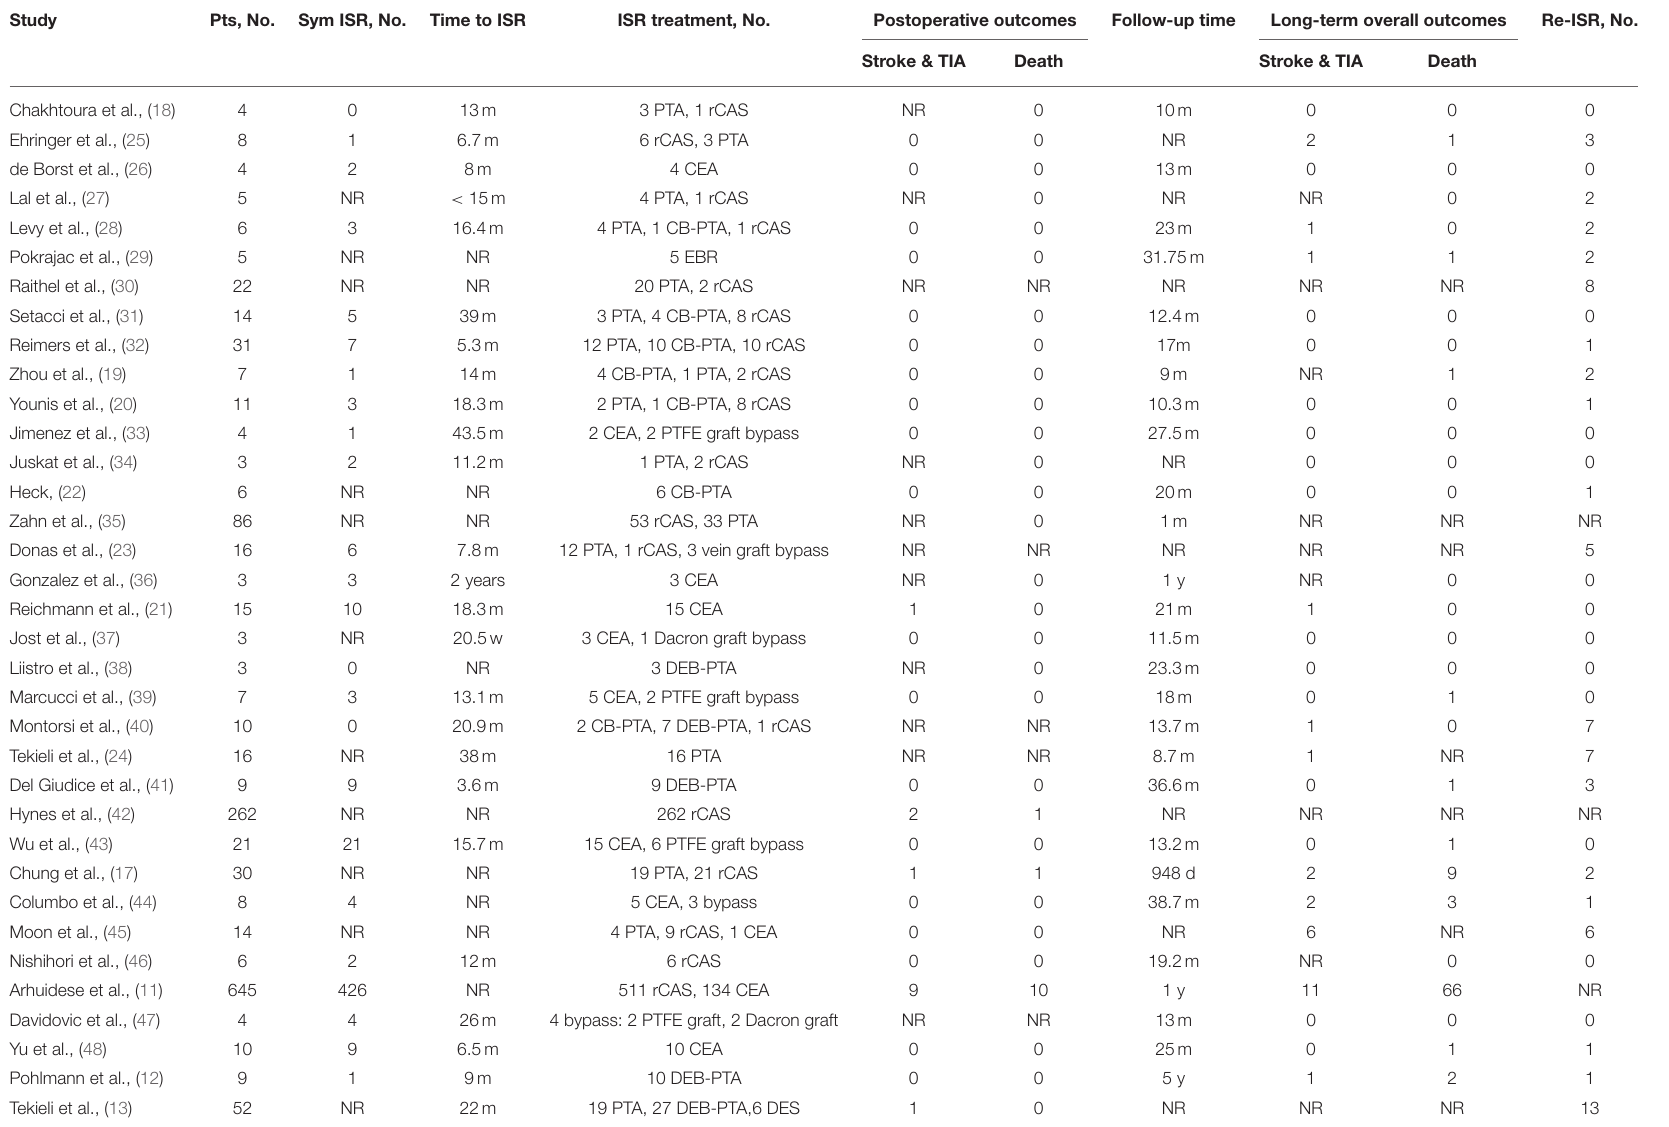
TABLE 2 | Summary of included